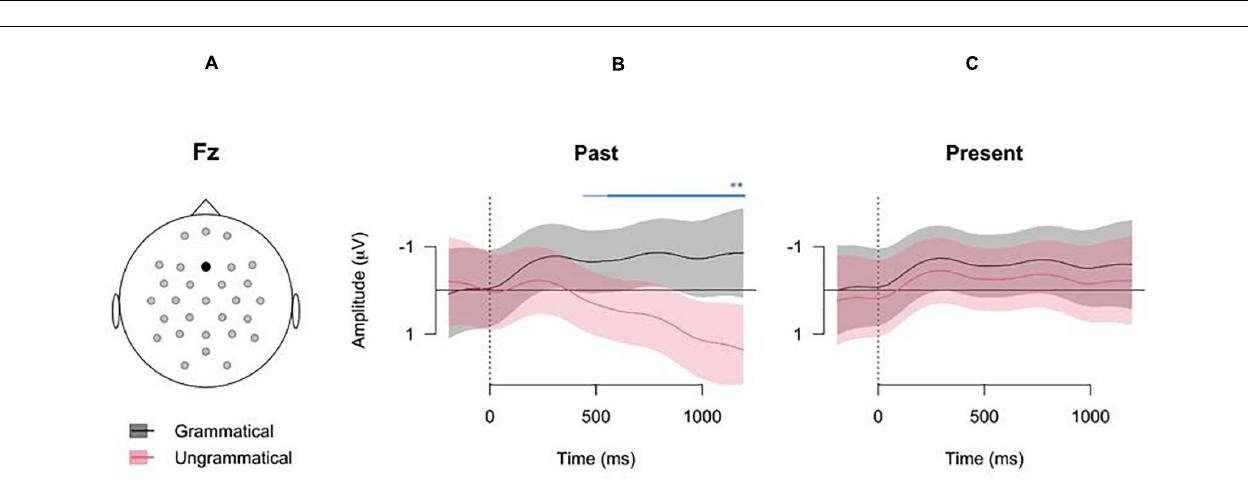
FIGURE 3 | Model estimates (i.e., summed effects, with random effects excluded) for the GAMM fitting the data of electrode Fz (error bars: pointwise CI, 95%). The x -axes show the time (in ms) from verb onset, and the y -axes show the estimated amplitudes (negative upward). (A) Electrode position. (B) Odel estimates of the grammatical past tense sentences (black line) and the ungrammatical past tense sentences (red line). (C) Model estimates of the grammatical present tense sentences (black line) and the ungrammatical present tense sentences (red line). The blue line in the center panel indicates the time window in which the model predicts a significant difference between the two grammaticality conditions. (The thin line is the estimated difference based on pointwise confidence intervals, whereas the thick lines are the estimated differences based on the simultaneous confidence